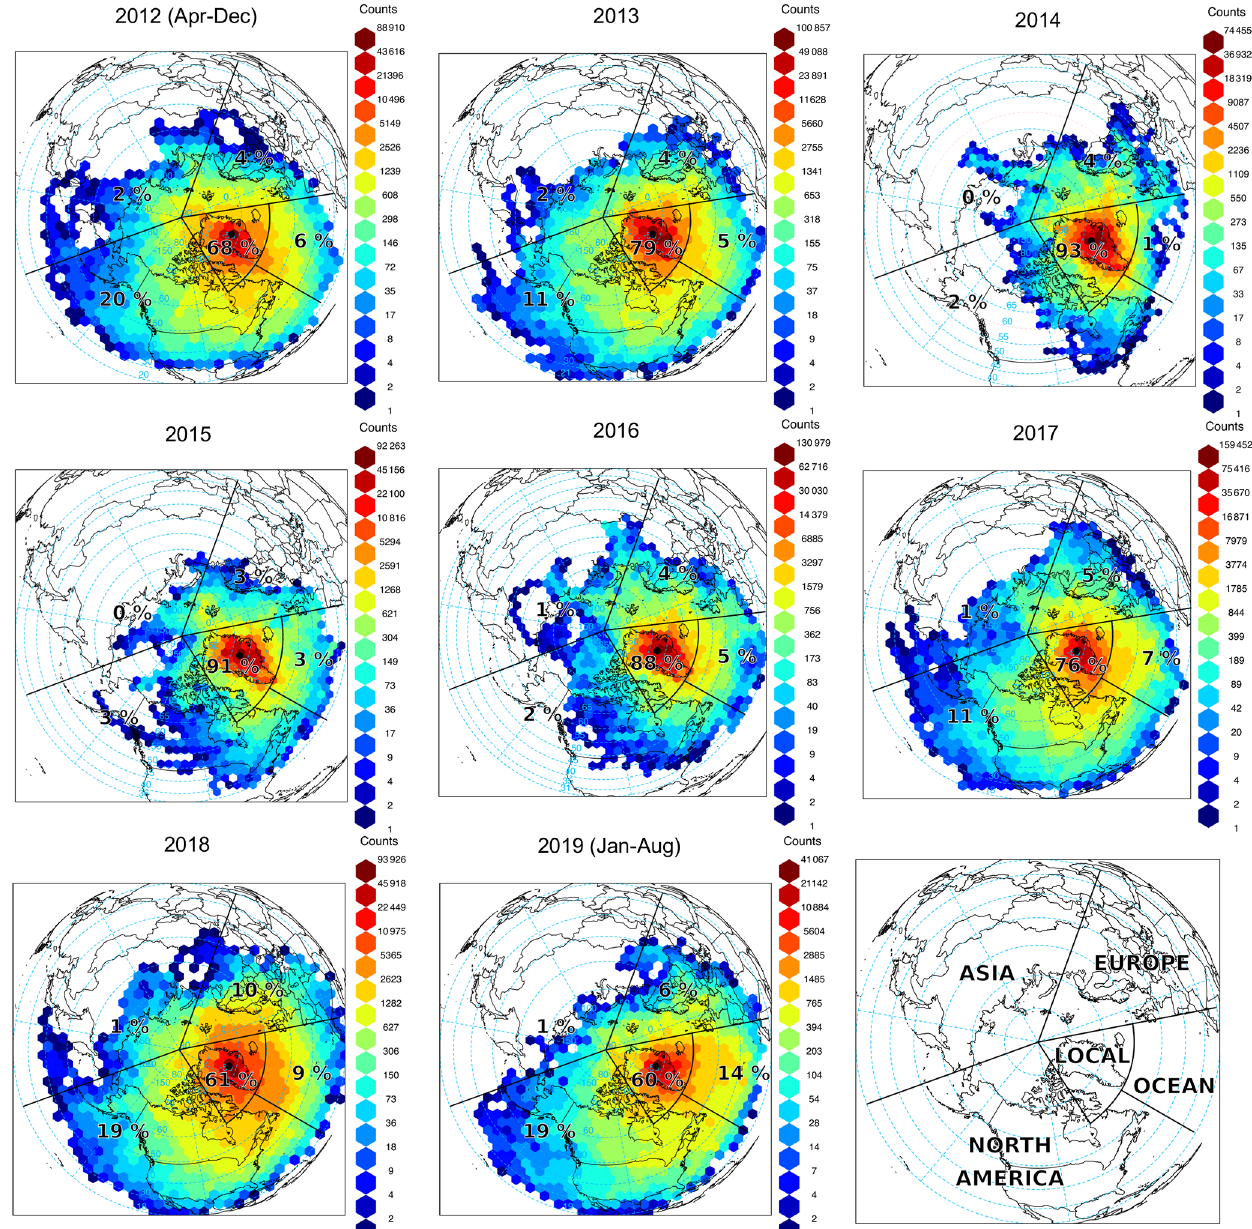
Figure 5. Origin of air masses influencing GEOSummit (black dot). Gridded back-trajectory frequencies using an orthogonal map projection (centered over the North Pole) with hexagonal binning. The tiles represent the number of incidences and the numbers the relative influence of the various